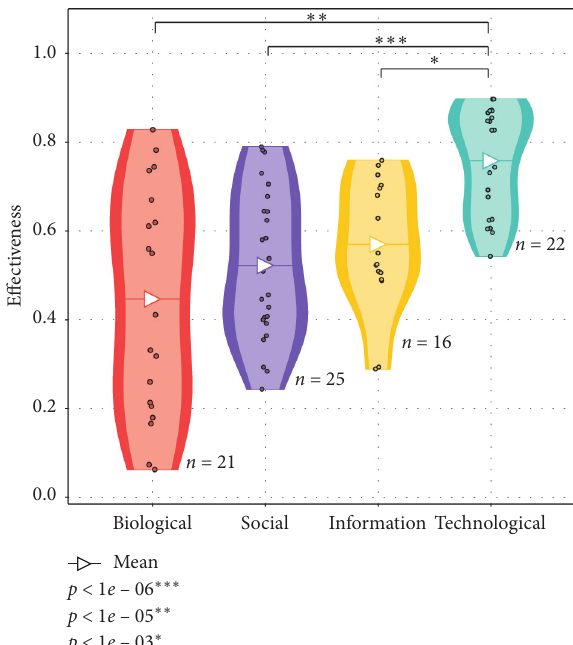
Figure 3: Effective information of real networks. Effectiveness, a ( N ) [11], of 84 real networks from network’s EI , normalized by log 2 the Konect network database [23], grouped by domain of origin. To look further at the names and domains of the networks in question, see SM V E Networks in different categories have varying effec- tiveness ( t -test, comparison of